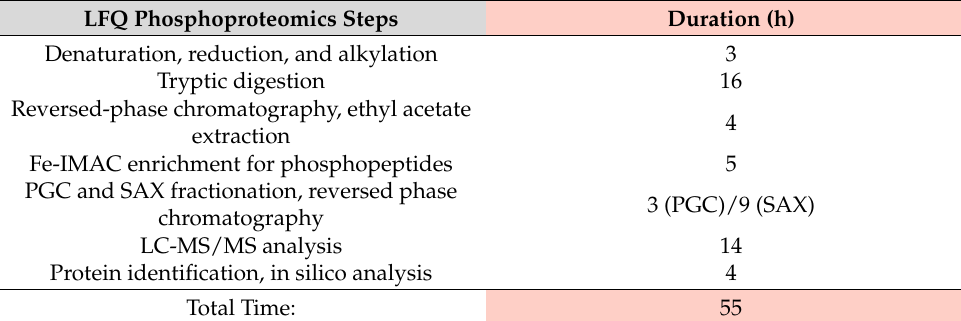
Table 2. Time-scale of individual steps of the LFQ phosphoproteomics workflow. LFQ Phosphoproteomics